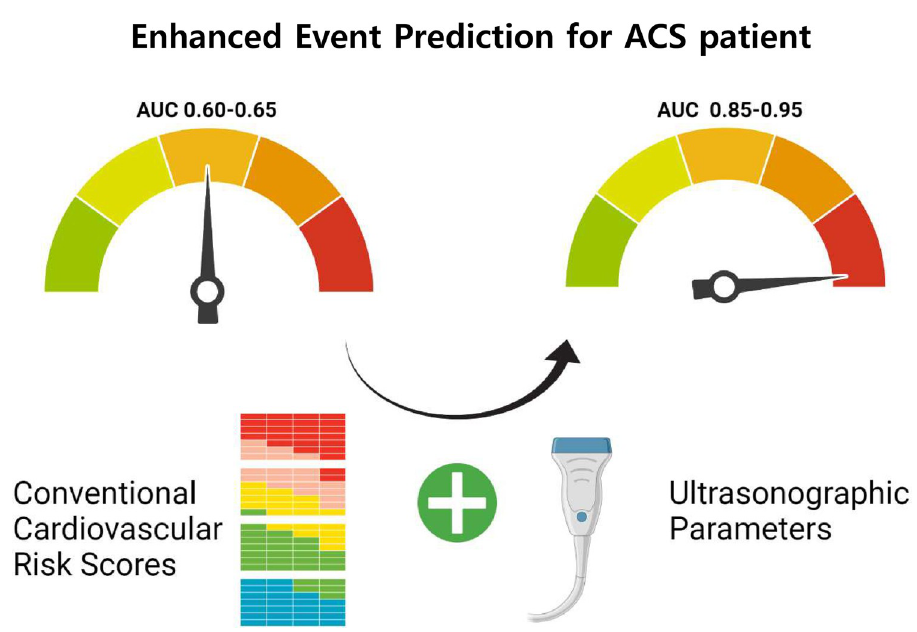
Fig 3. A graphical illustration of key findings. The improvement of predictive performance of the novel risk prediction models for asymptomatic carotid stenosis using combination with ultrasonographic parameters and conventional cardiovascular risk scores. Abbreviations: ACS, asymptomatic carotid